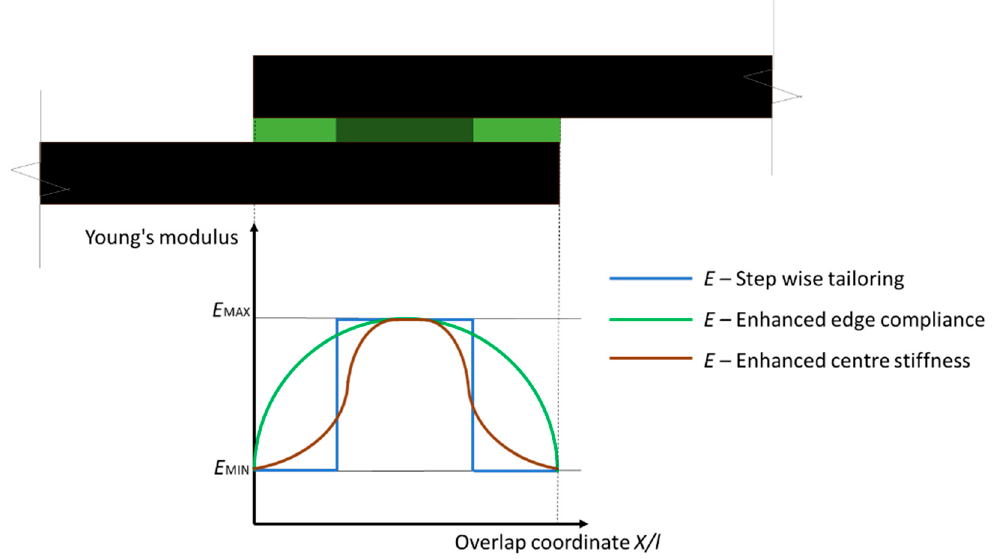
Figure 3. Bond line modulus tailoring using digital materials for single lap joints (SLJs) [23,24].